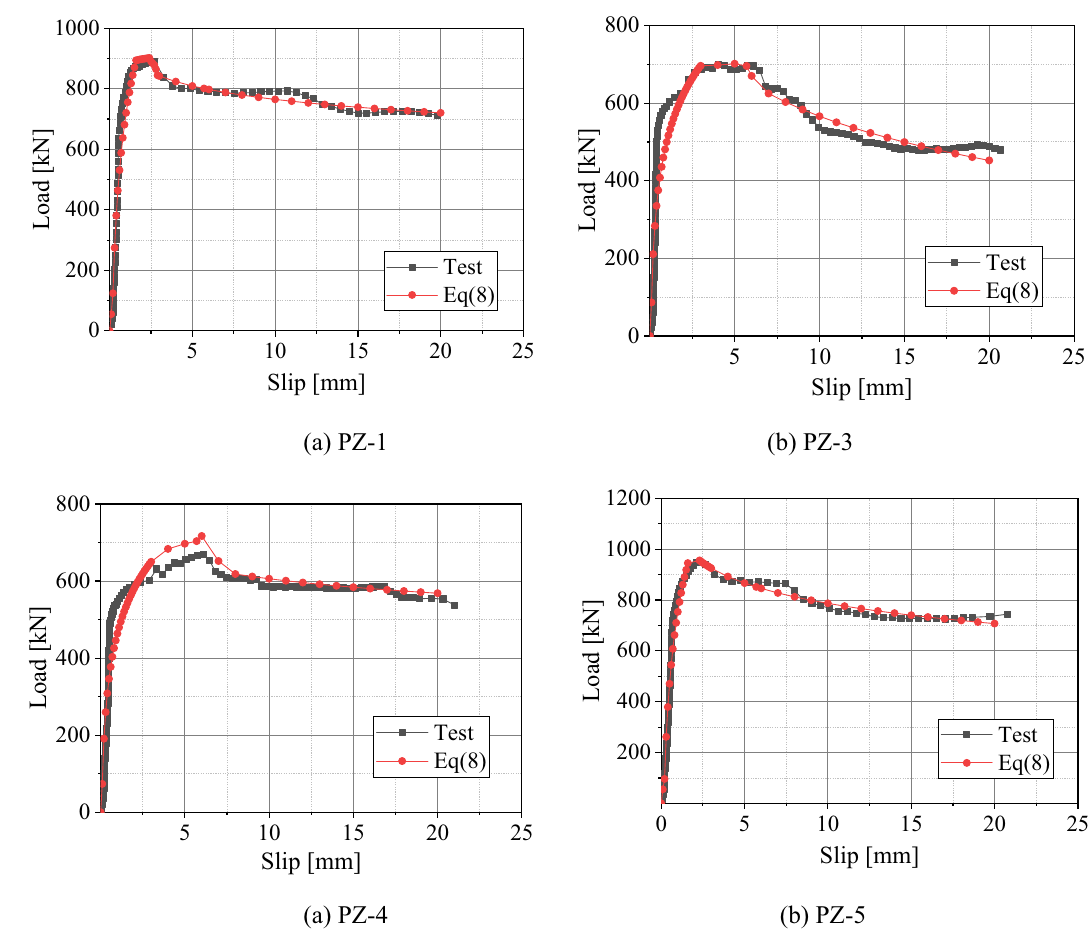
Figure 15. Comparison of load–slip curves between the test results and the fitting